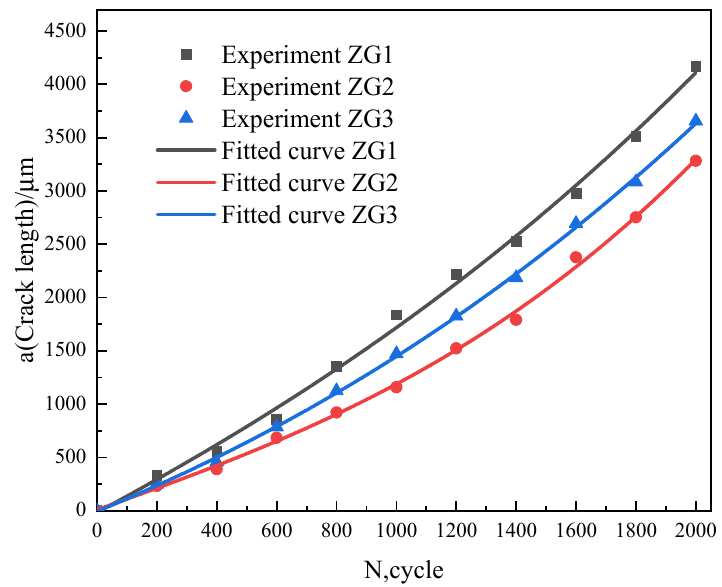
Figure 3. The a-N curves of the thermal fatigue cycle.